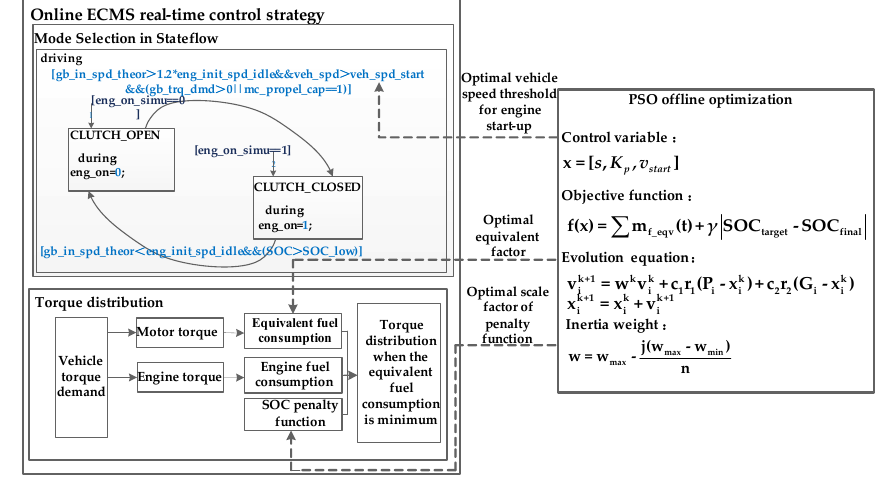
Figure 16. The flow chart of PSO-ECMS.